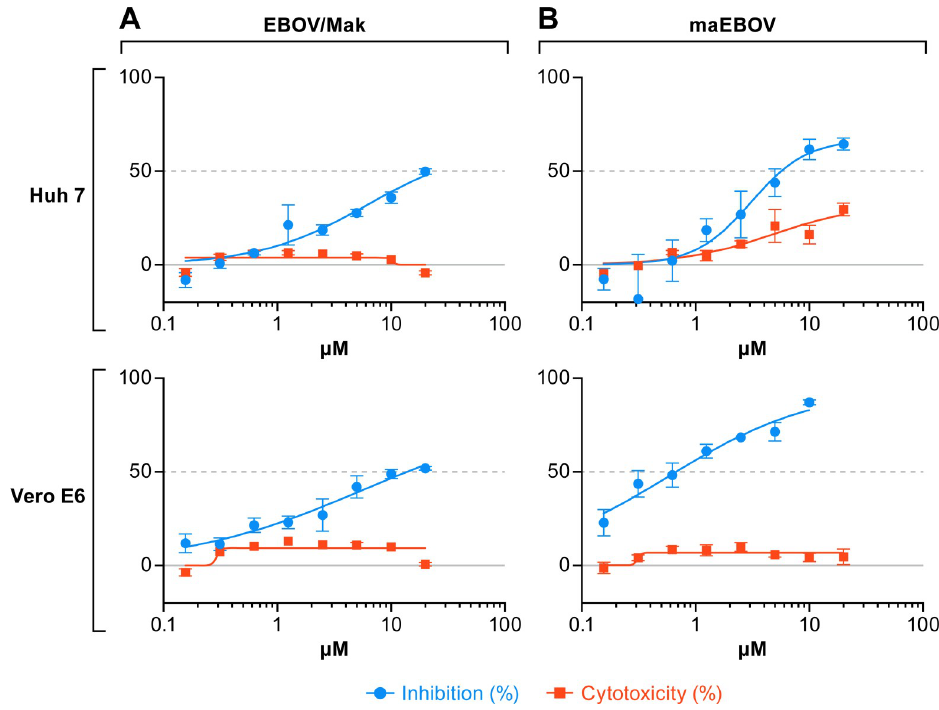
Fig 2. H84T inhibits human- and mouse-adapted Ebola virus replication in tissue culture. Huh 7 or Vero E6 cells were pretreated for 1 h with the indicated concentrations of H84T. Cells were subsequently infected with (A) EBOV/ Mak at an MOI of 0.5 or (B) ma-EBOV at an MOI of 0.25 for 48 h. Cells were fixed and stained with an antibody to the EBOV VP40 protein followed by secondary staining with an HRP-labeled antibody. Antiviral activity of H84T, shown in blue, and cytotoxicity in uninfected cells, shown in red, were calculated as described in the Methods section. The experiment depicted in (A) was run twice for each cell line, and each experiment comprised duplicate plates with triplicate wells per dose (mean ± SD; n = 3). One representative graph from the two independent experiments (total of 4 plates) is shown. In (B), one experiment was run on a single plate with triplicate wells per dose (mean ± SD; n = 3). Average cytotoxicities (with 20 μ M H84T) were 4.2% and 3.0% for Huh 7 and Vero cells, respectively (from n = 5 plates each). Abbreviations: EBOV/Mak, Ebola virus (Makona); HRP, horseradish peroxidase; ma-EBOV, mouse- adapted Ebola virus; MOI, multiplicity of infection; SD, standard deviation; VP40, viral protein